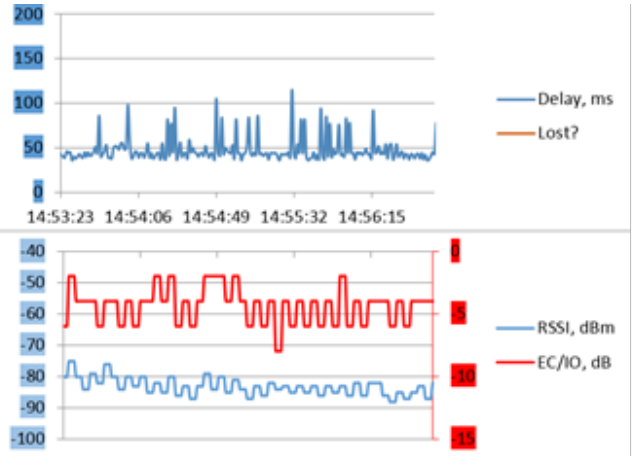
Fig. 3. Network performance for the immovable UE placed on the ground.